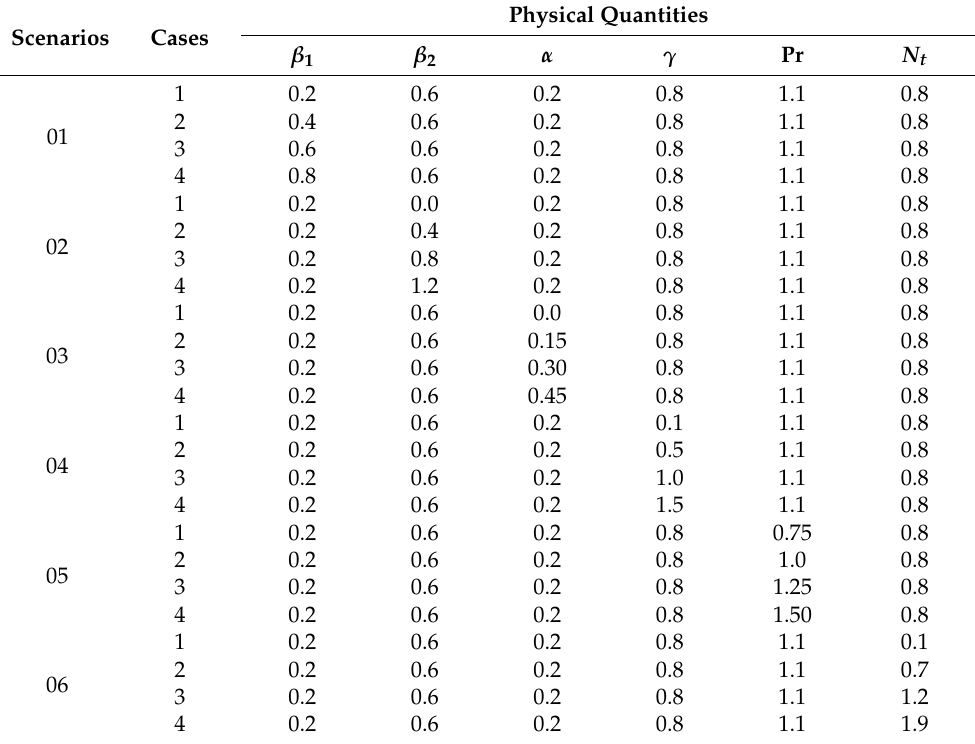
Table 1. Variation of parameters of